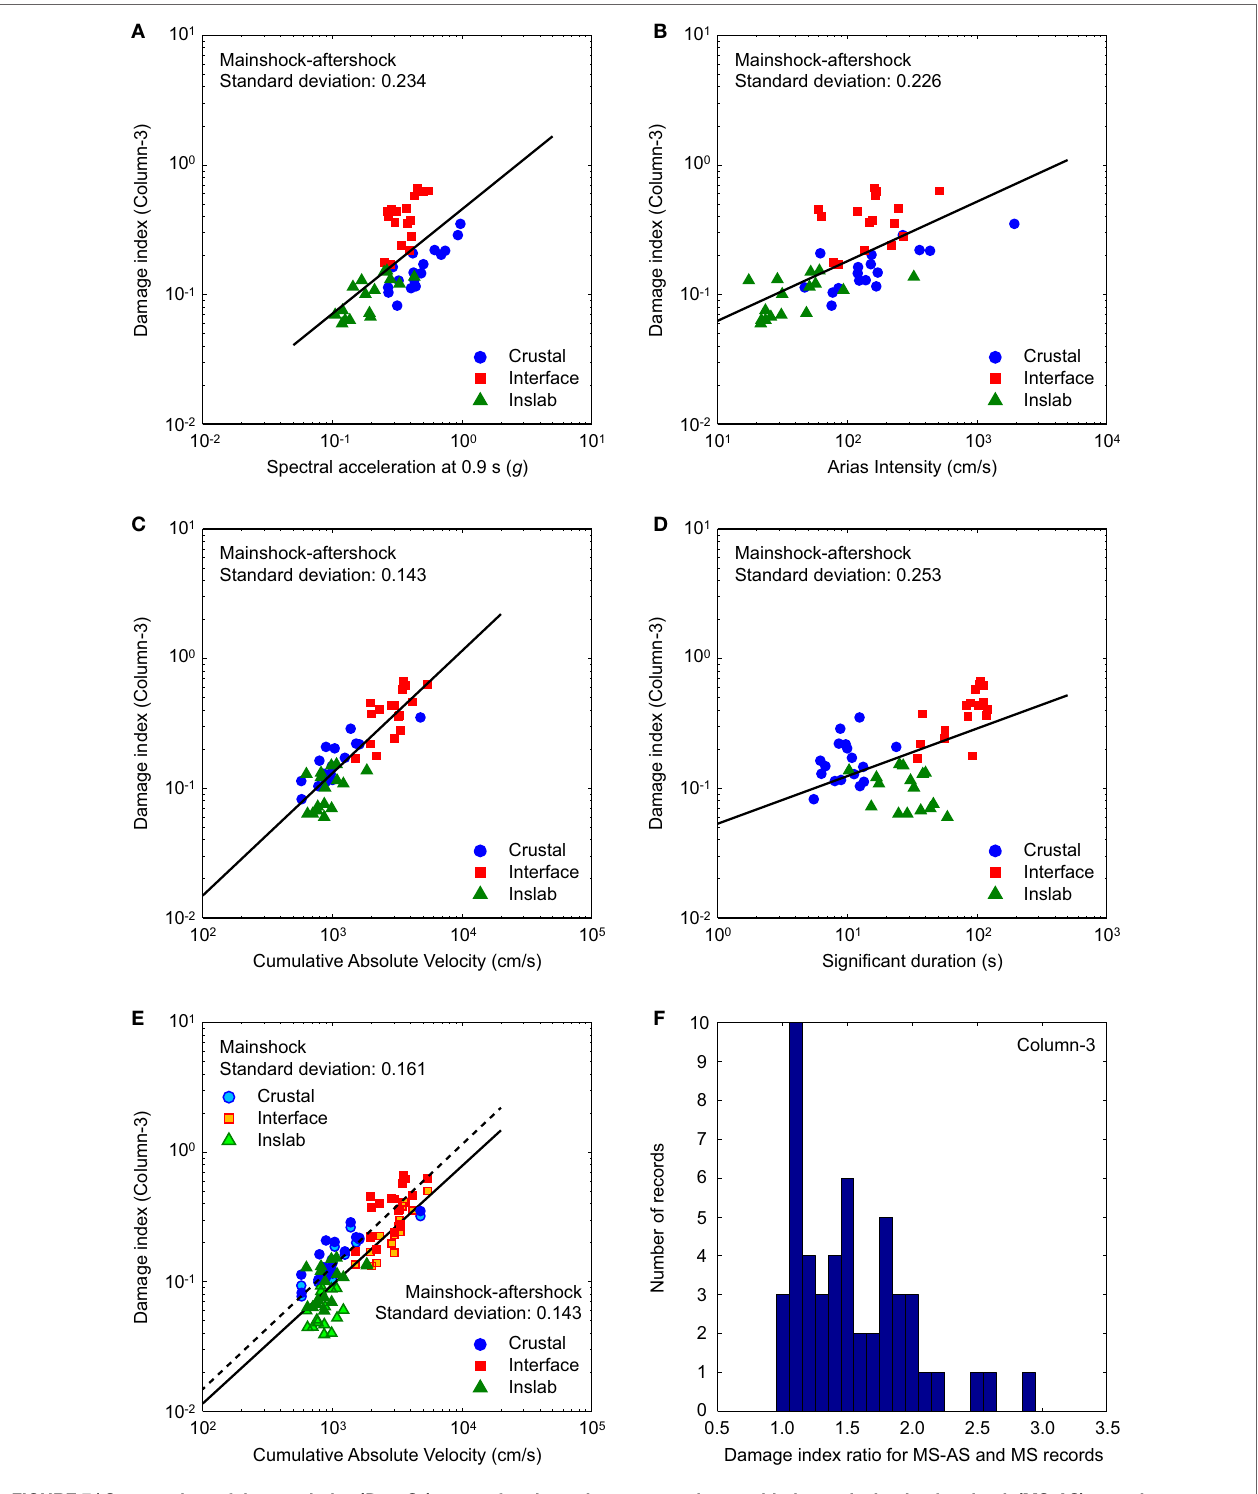
FIGURE 7 | Scatter plots of damage index ( D MD -C 3 ) versus four intensity measures by considering mainshock–aftershock (MS-AS) records: (A) spectral acceleration at 0.9s, (B) Arias intensity, (C) cumulative absolute velocity, and (D) significant duration . (E) Scatter plot of damage index ( D MD -C 3 ) versus cumulative absolute velocity by considering MS records and MS-AS records. (F) Histogram of the damage index ratios ( D MD -C 3 ) between MS-AS records and MS records.